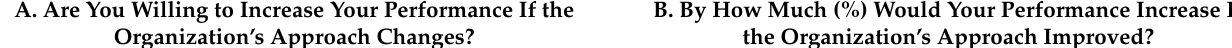
Table 3. The willingness of respondents to increase creative performance if the approach on the part of the organization changes (employees’ responses).